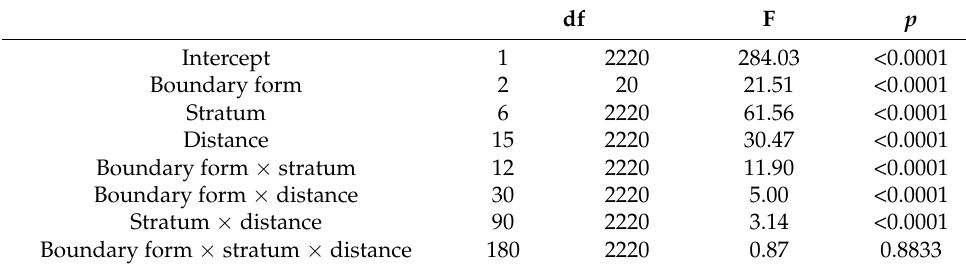
Table 1. The summary results of linear mixed models testing the effect of boundary form (concave, straight, and convex), stratum (7 levels), and distance (16 levels) on the cover of woody vegetation colonizing the mines. The F-values of the fixed factors and their significance are